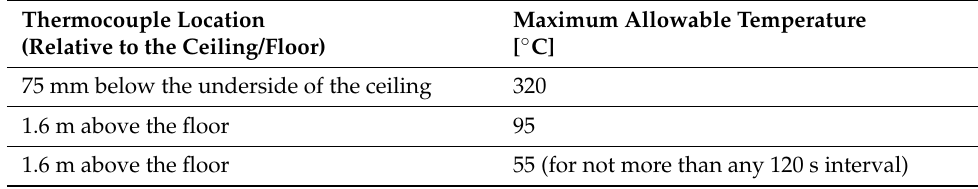
Table 1. BS 8458:2015 test criteria.